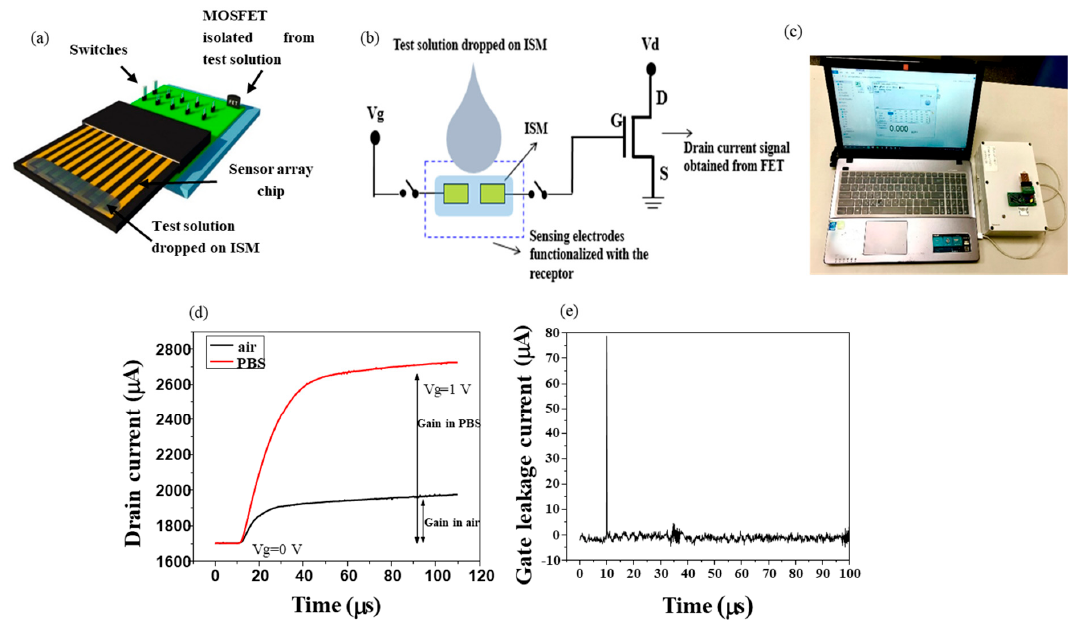
Figure 1. ( a ) Schematic representation of extended gate Hg-ISMFET connected to the prototype. ( b ) Structural representation of extended gate Hg-ISMFET. ( c ) Real view image of sensor chip mounted on the portable measurement system connected to personal computer. ( d ) Current gain average verses time in air and in 0.02X PBS by extended gate Hg-ISMFET. ( e ) Gain leakage current of ISMFET in the presence of 10 − 8 M mercury ions.